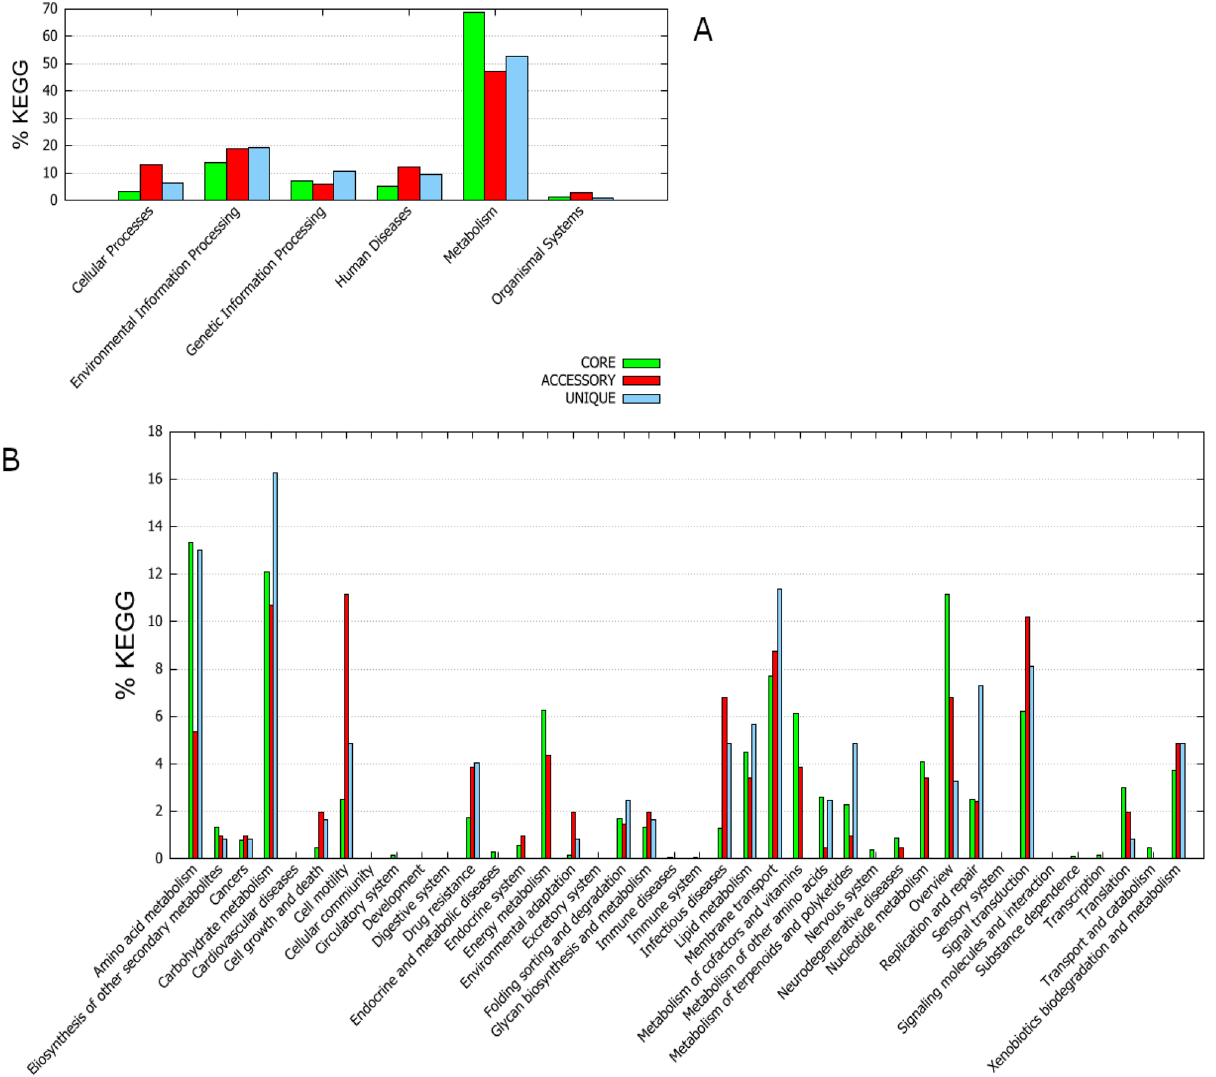
Figure 3. KEGG distribution of P. psychrophila pangenome. ( A ) General distribution; ( B ) details